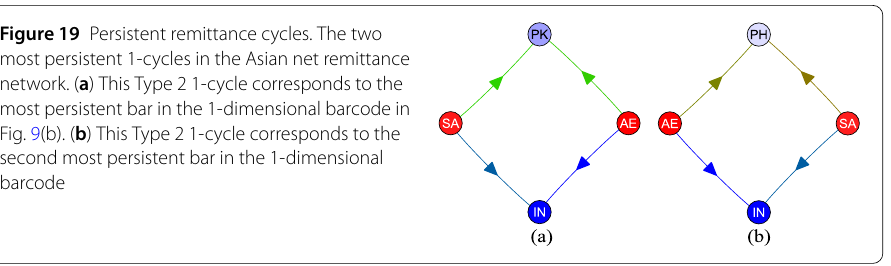
Availability of data and materials All data sets used in this study are available from the corresponding databases mentioned in the text. The net migration and remittance matrix is available upon